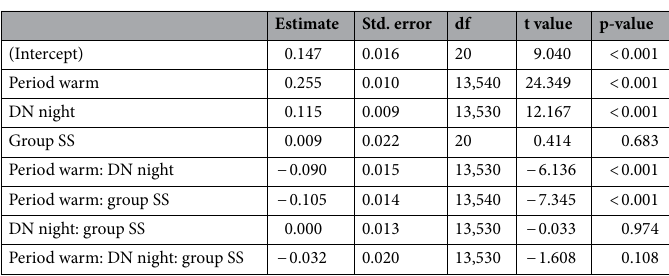
Table 3. Results of the linear mixed effects model testing the effect of period (warm and cold), day/night time (DN), and group ( SS shallow/shallow, DS deep/shallow) on the vertical activity of the fish (variance of depth per each day/night